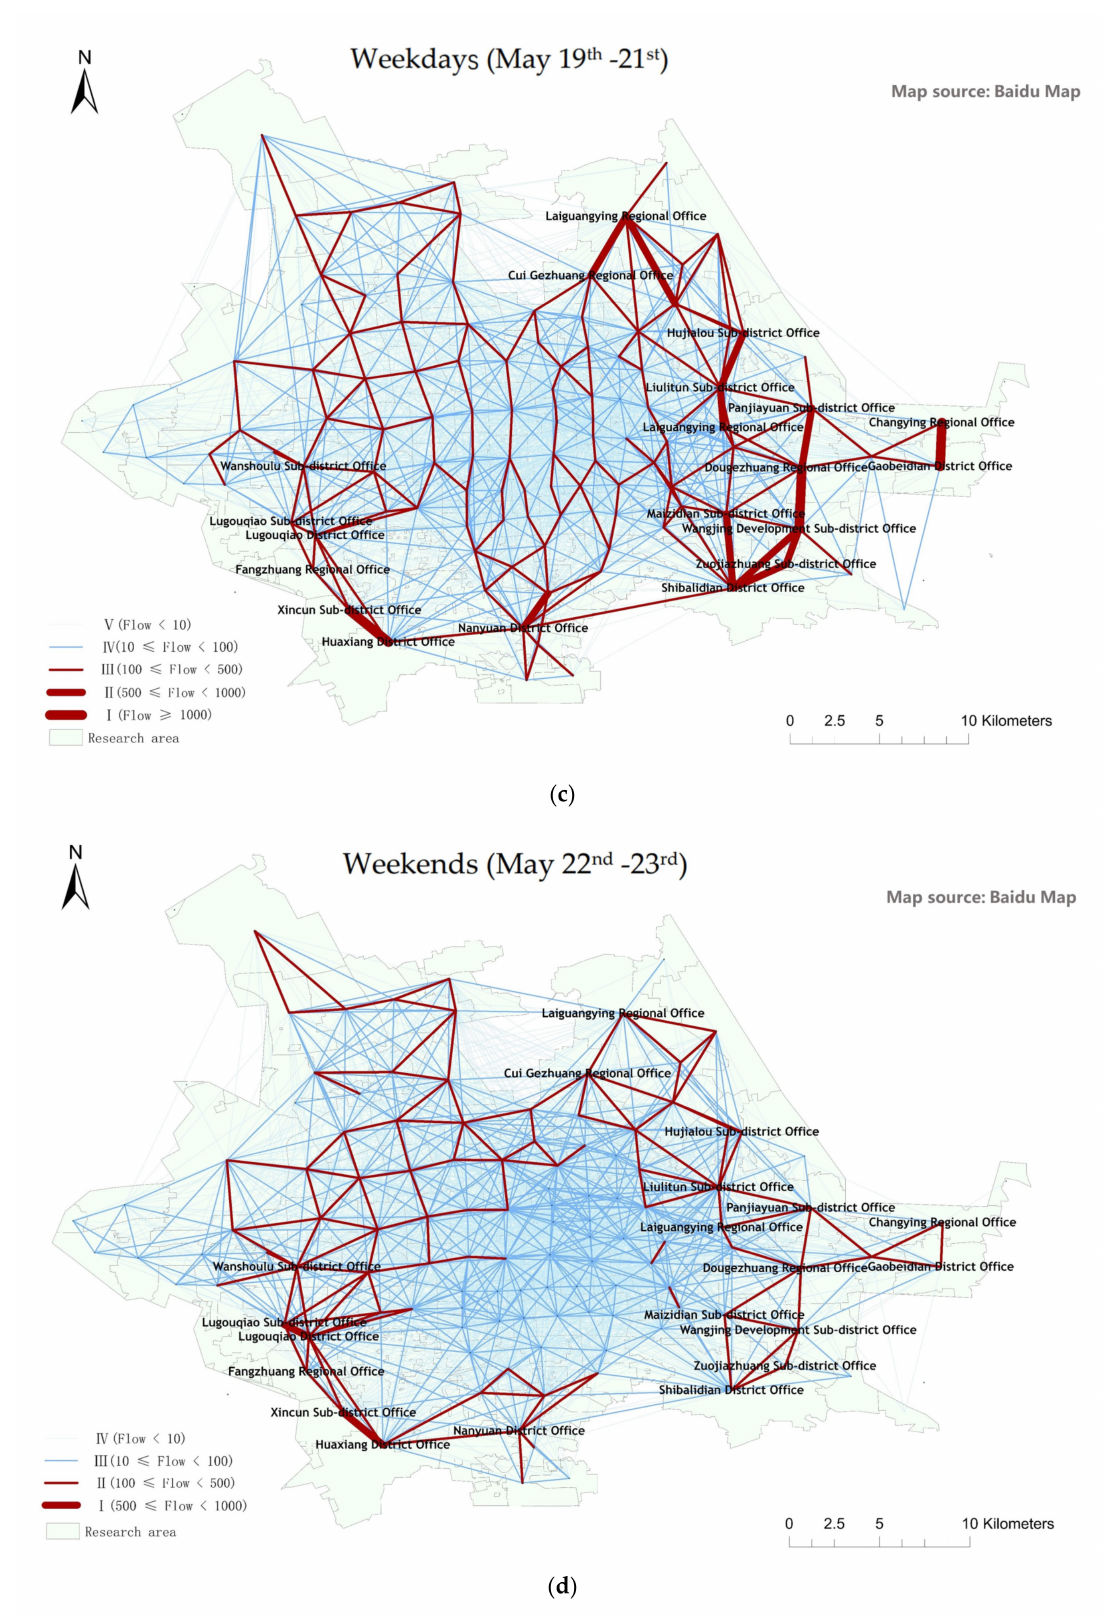
Figure 5. Bike travel network structure: ( a ) Weekday (17 May); ( b ) Weekday (18 May); ( c ) Weekdays (19–21 May); ( d ) Weekends (22–23